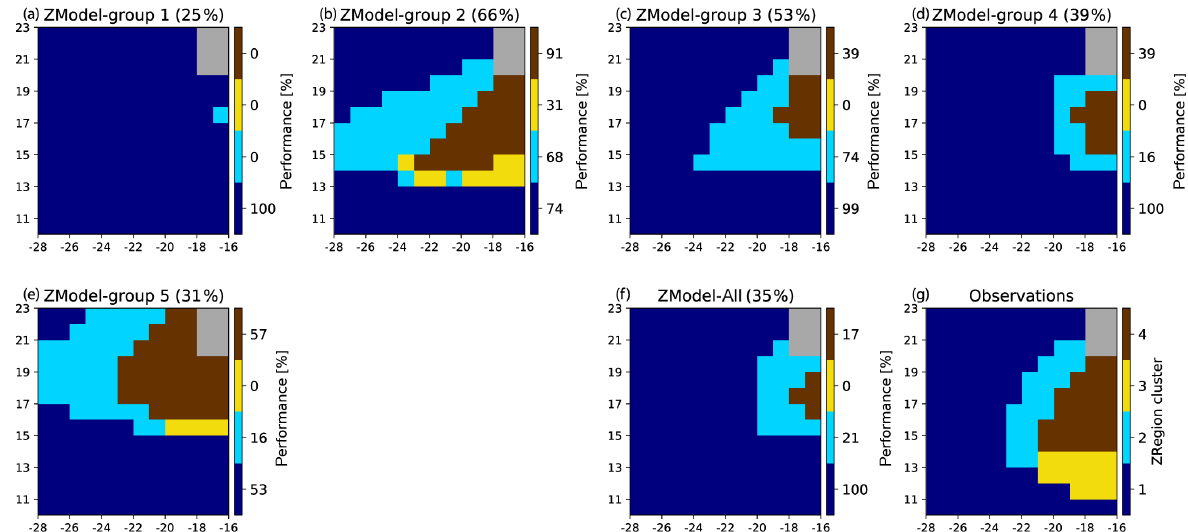
Figure 8. (a–e) Projection of the multi-model ensembles (ZModel groups) onto the ZSOM. The performances are given on top of each panel. The ZRegion clusters determined by processing the observations in the zoomed region and their associated colors are given in panel (g) . The color bars at the right of each multi-ensemble panel represent the skill (in %) associated with each ZRegion cluster. Panel (f) shows the same for the full multi-model ensemble. Panel (g) reproduces the region clusters based on the observations also shown in Fig. 6.